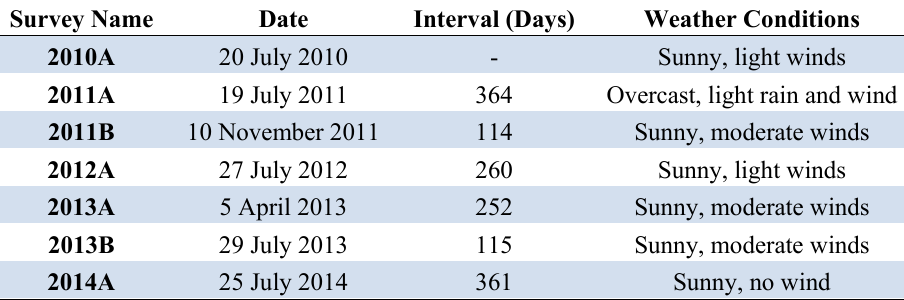
Table 1. Details of aerial surveys of Home Hill